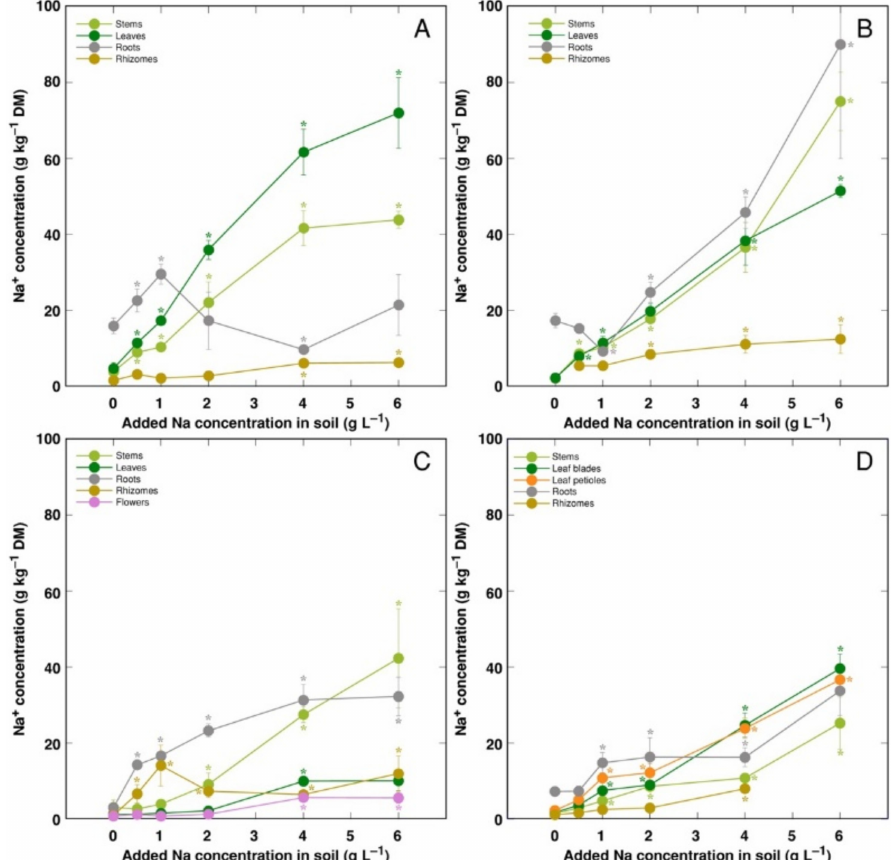
Figure 5. Changes in Na + concentration under the effect of increasing soil salinity in different parts of Calystegia sepium accessions CSe1 ( A ), CSe2 ( B ), CSe3 ( C ) and Calystegia soldanella ( D ). Na + was added in a form of NaCl. Data are means from three replicates for each concentration ± SE. Asterisks of the respective color indicate statistically significant differences ( p < 0.05) from